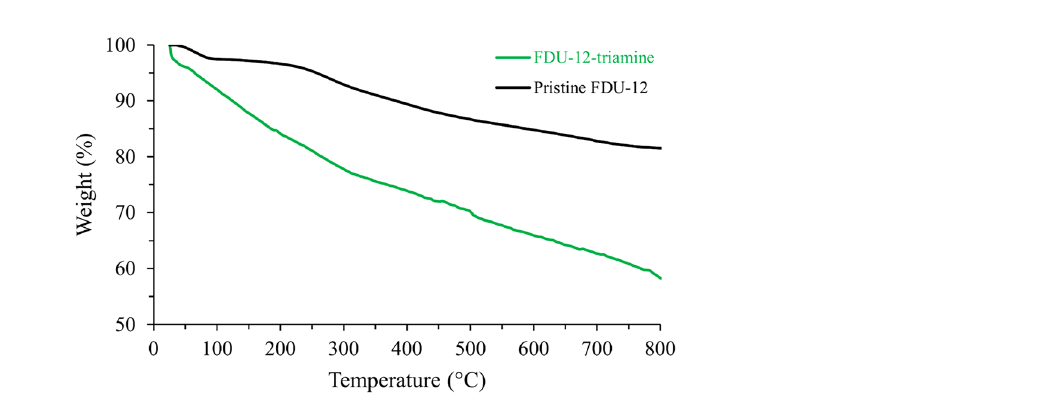
Figure 5. TGA curves of pristine FDU-12 and